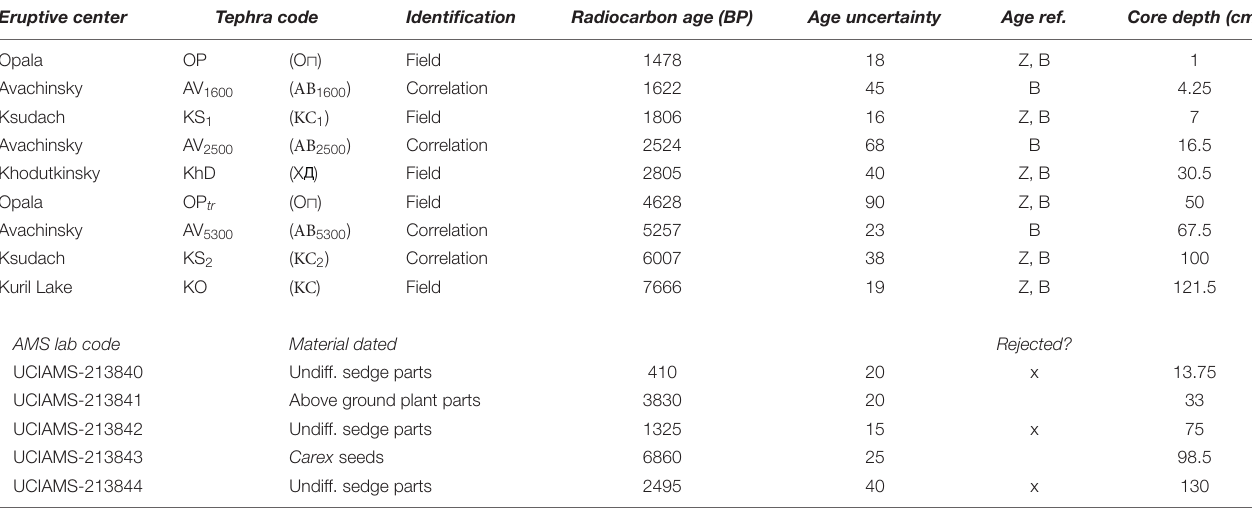
TABLE 1 | Age control data for Newmarket Fen.